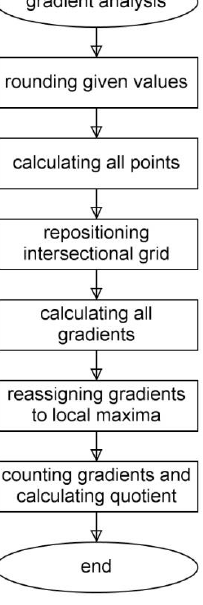
Figure 5. Steps of an up to date gradient analysis.